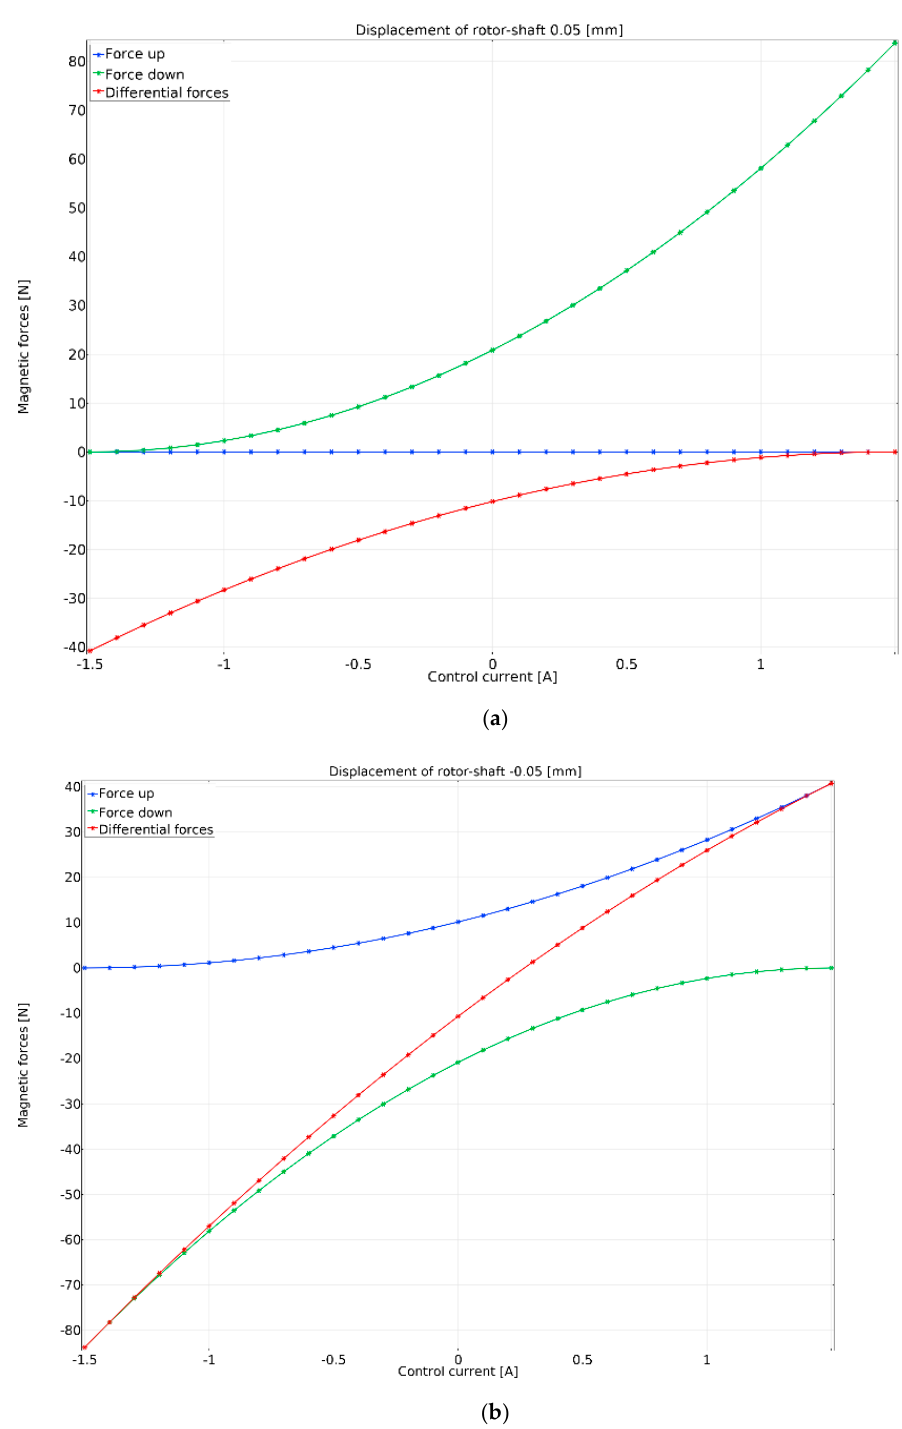
Figure 13. Magnetic forces vs. displacements of the rotor–shaft raceway equal to 0.05 mm ( a ) and − 0.05 mm ( b ).